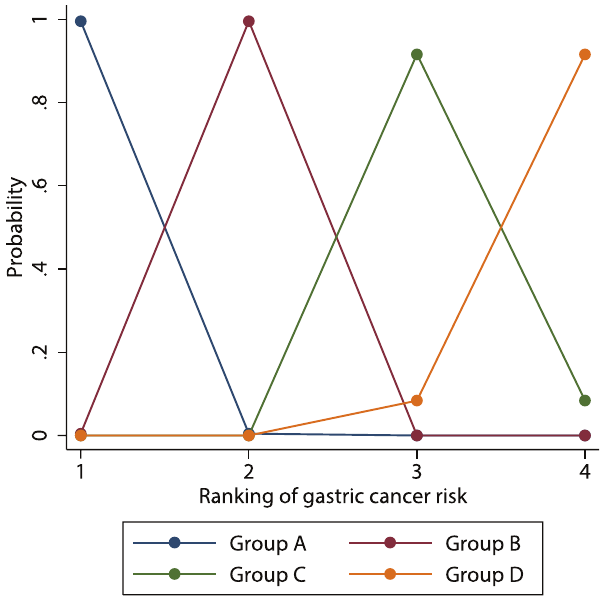
Figure 3. Rankogram of risk of gastric cancer development based on four-risk-group prediction model. Ranking probability of gastric cancer risk for each group, estimated from direct multivariate meta-analysis is shown. The 4 rankings show the risk of gastric cancer development: rank 1, lowest risk; rank 2, second lowest risk; rank 3, second highest risk; and rank 4, highest risk.